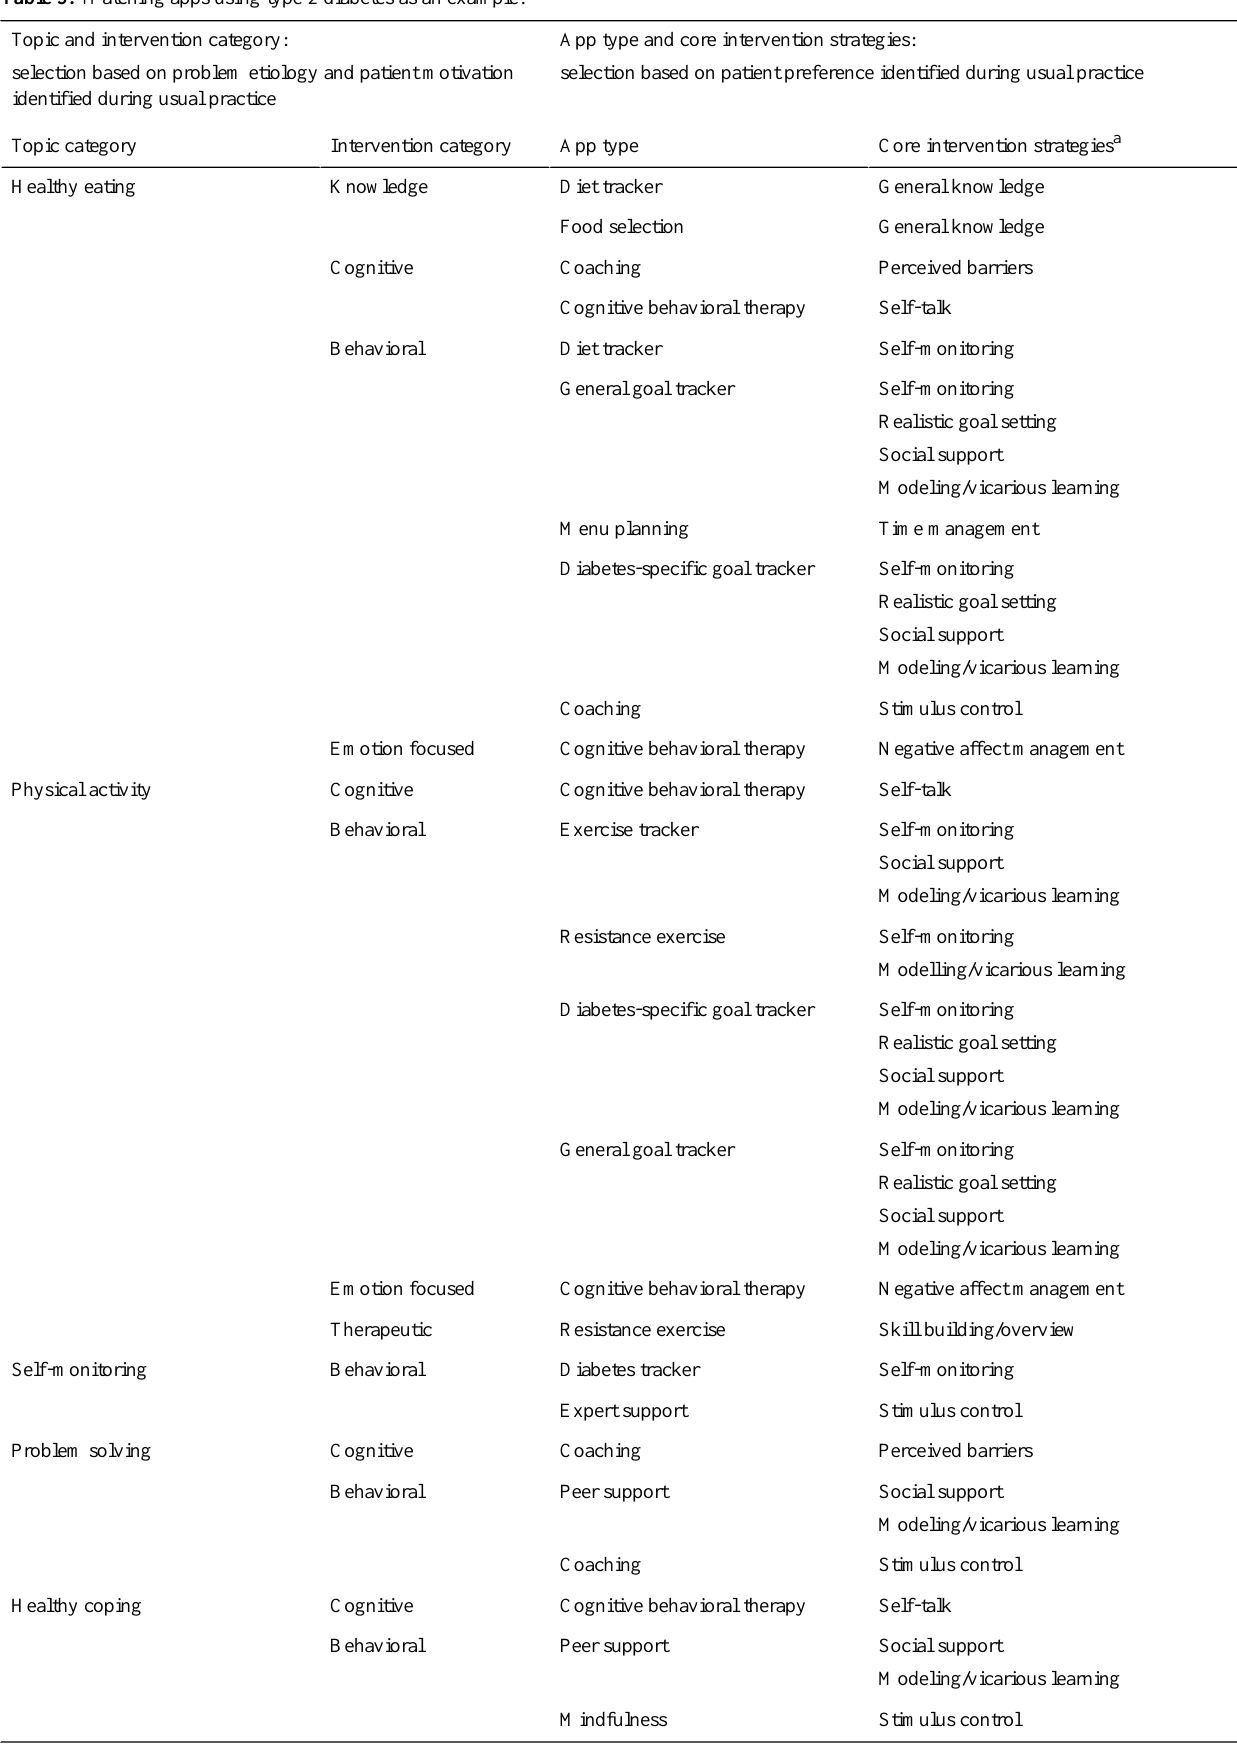
Table 5. Matching apps using type 2 diabetes as an example.